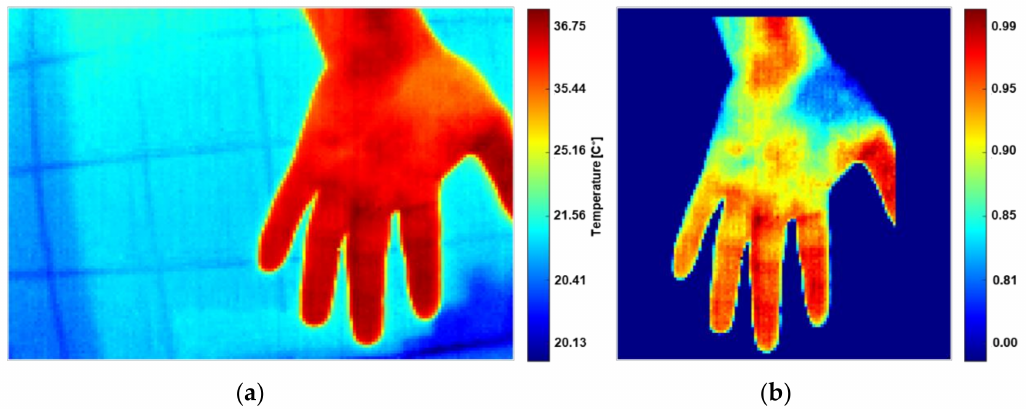
Figure 15. ( a ) Raw IR image, ( b ) segmentation of the RoI, and removal of artifacts.